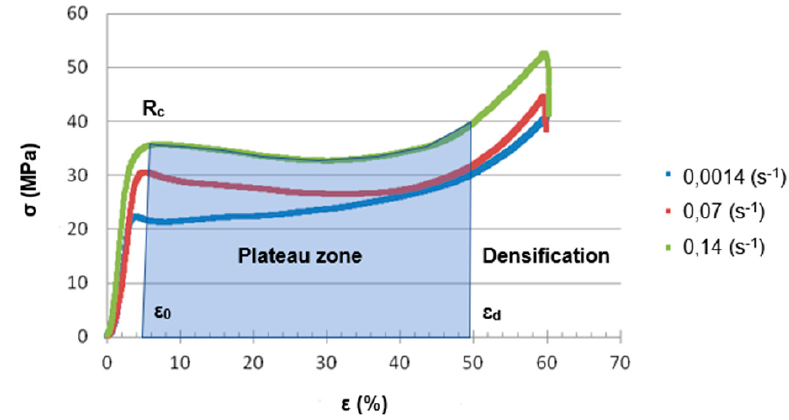
where 0 was the failure strain of the ceramic preform and ε d was the densification strain which corresponds to the turning point from the plateau stage to the densification stage on the stress–strain curve as well as the extreme value on the energy absorption efficiency [33].